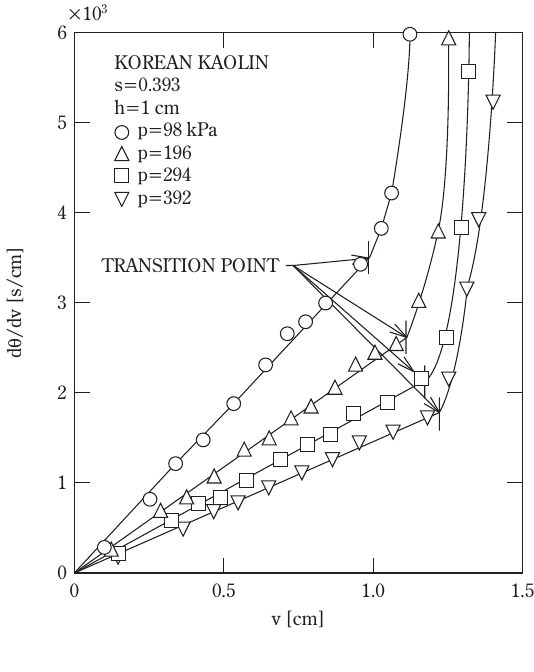
Fig. 2 Relation between reciprocal filtration rate and filtrate vol- ume per unit medium area for various applied filtration pressures.